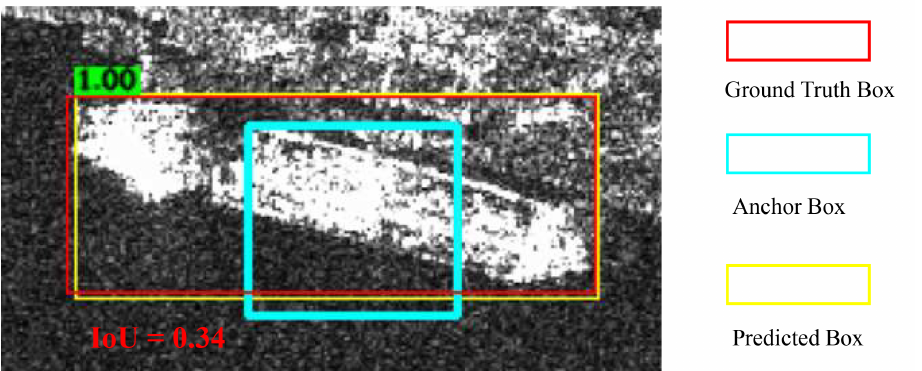
Figure 1. Visualization of the detection result of the original label assignment strategy. The red bounding box denotes the ground-truth object. The water green bounding box denotes the anchor box used to predict the ground-truth object. The yellow bounding box denotes the detection result corresponding to the anchor box.